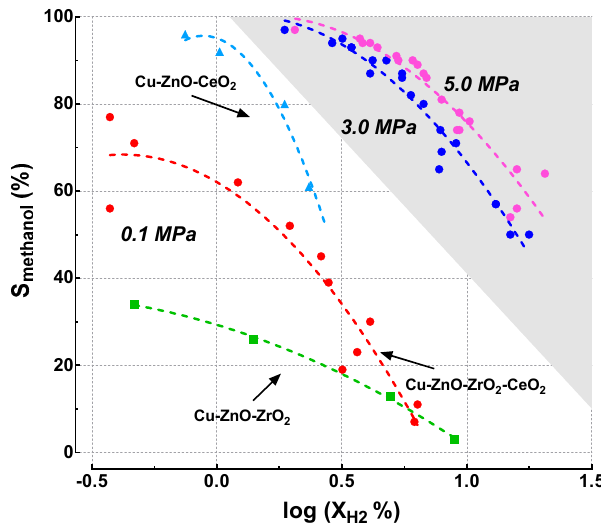
Figure 4. Activity pattern in the CO 2 hydrogenation reaction.